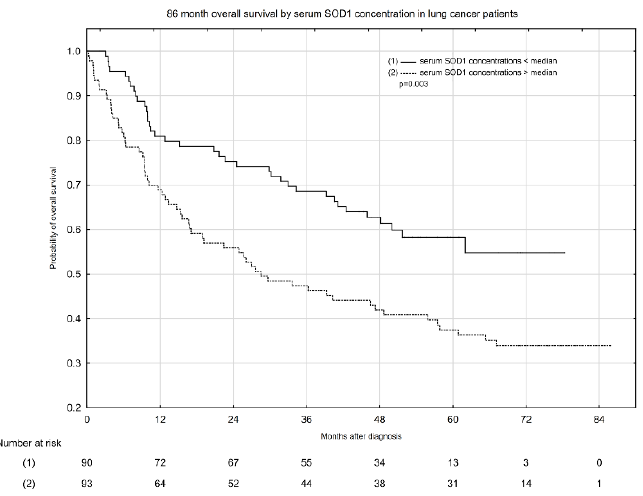
Figure 2. Eighty-six-month overall survival by serum SOD1 concentration in lung cancer patients.